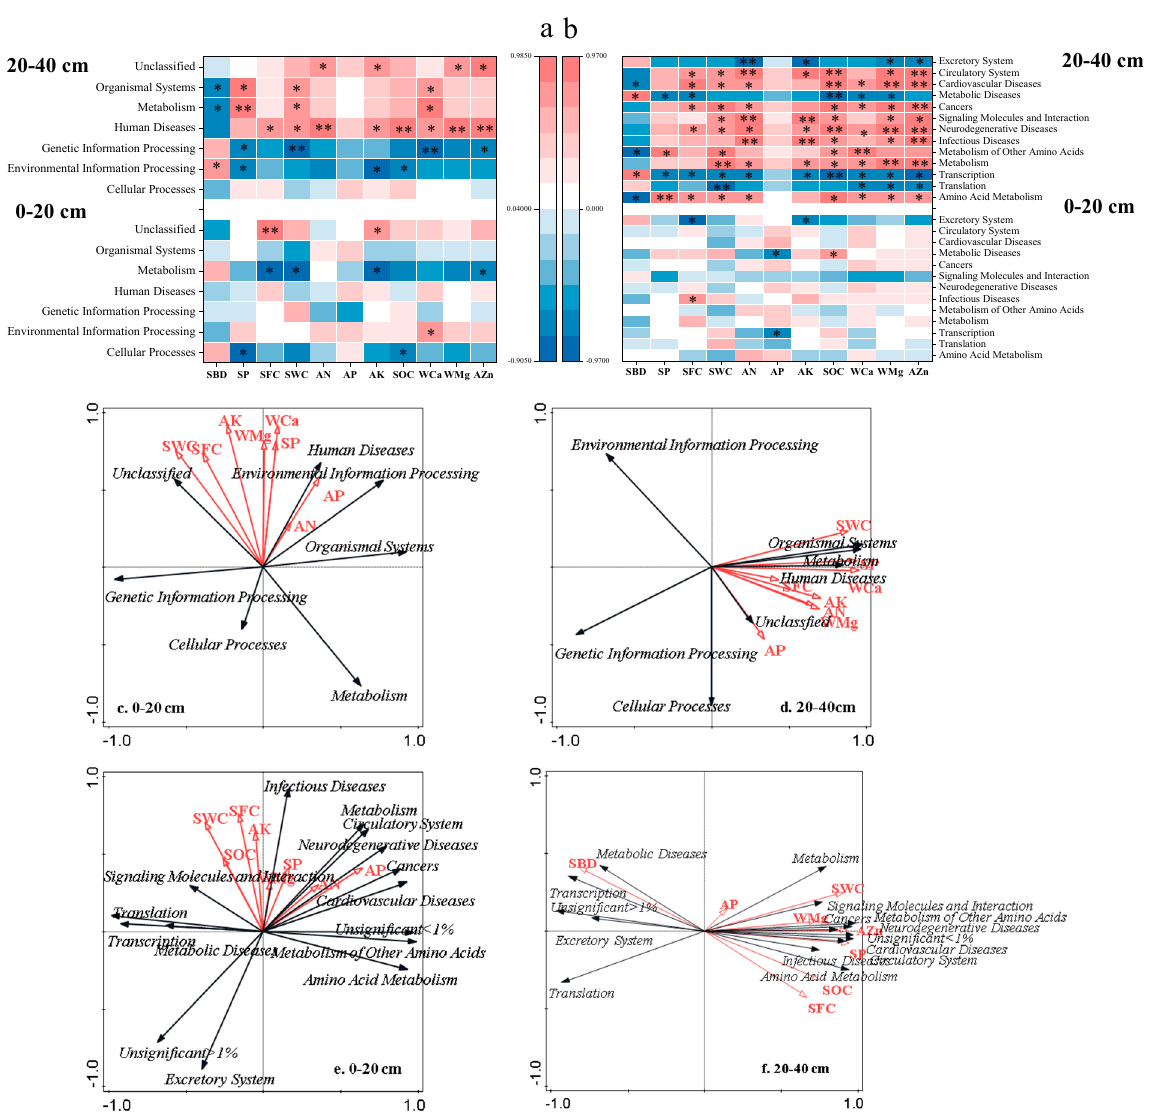
Figure 5. Analysis of soil bacterial functions as affected by soil property. Spearman correlation analysis between soil characteristics and functions in biochemical metabolic pathways ( a ); and sub ‐ functions ( b ). Redundancy analysis of the relationship between soil characteristics and functionality (biochemical metabolic pathways, ( c , d ); sub ‐ functions, ( e , f ). * indicates significant correla ‐